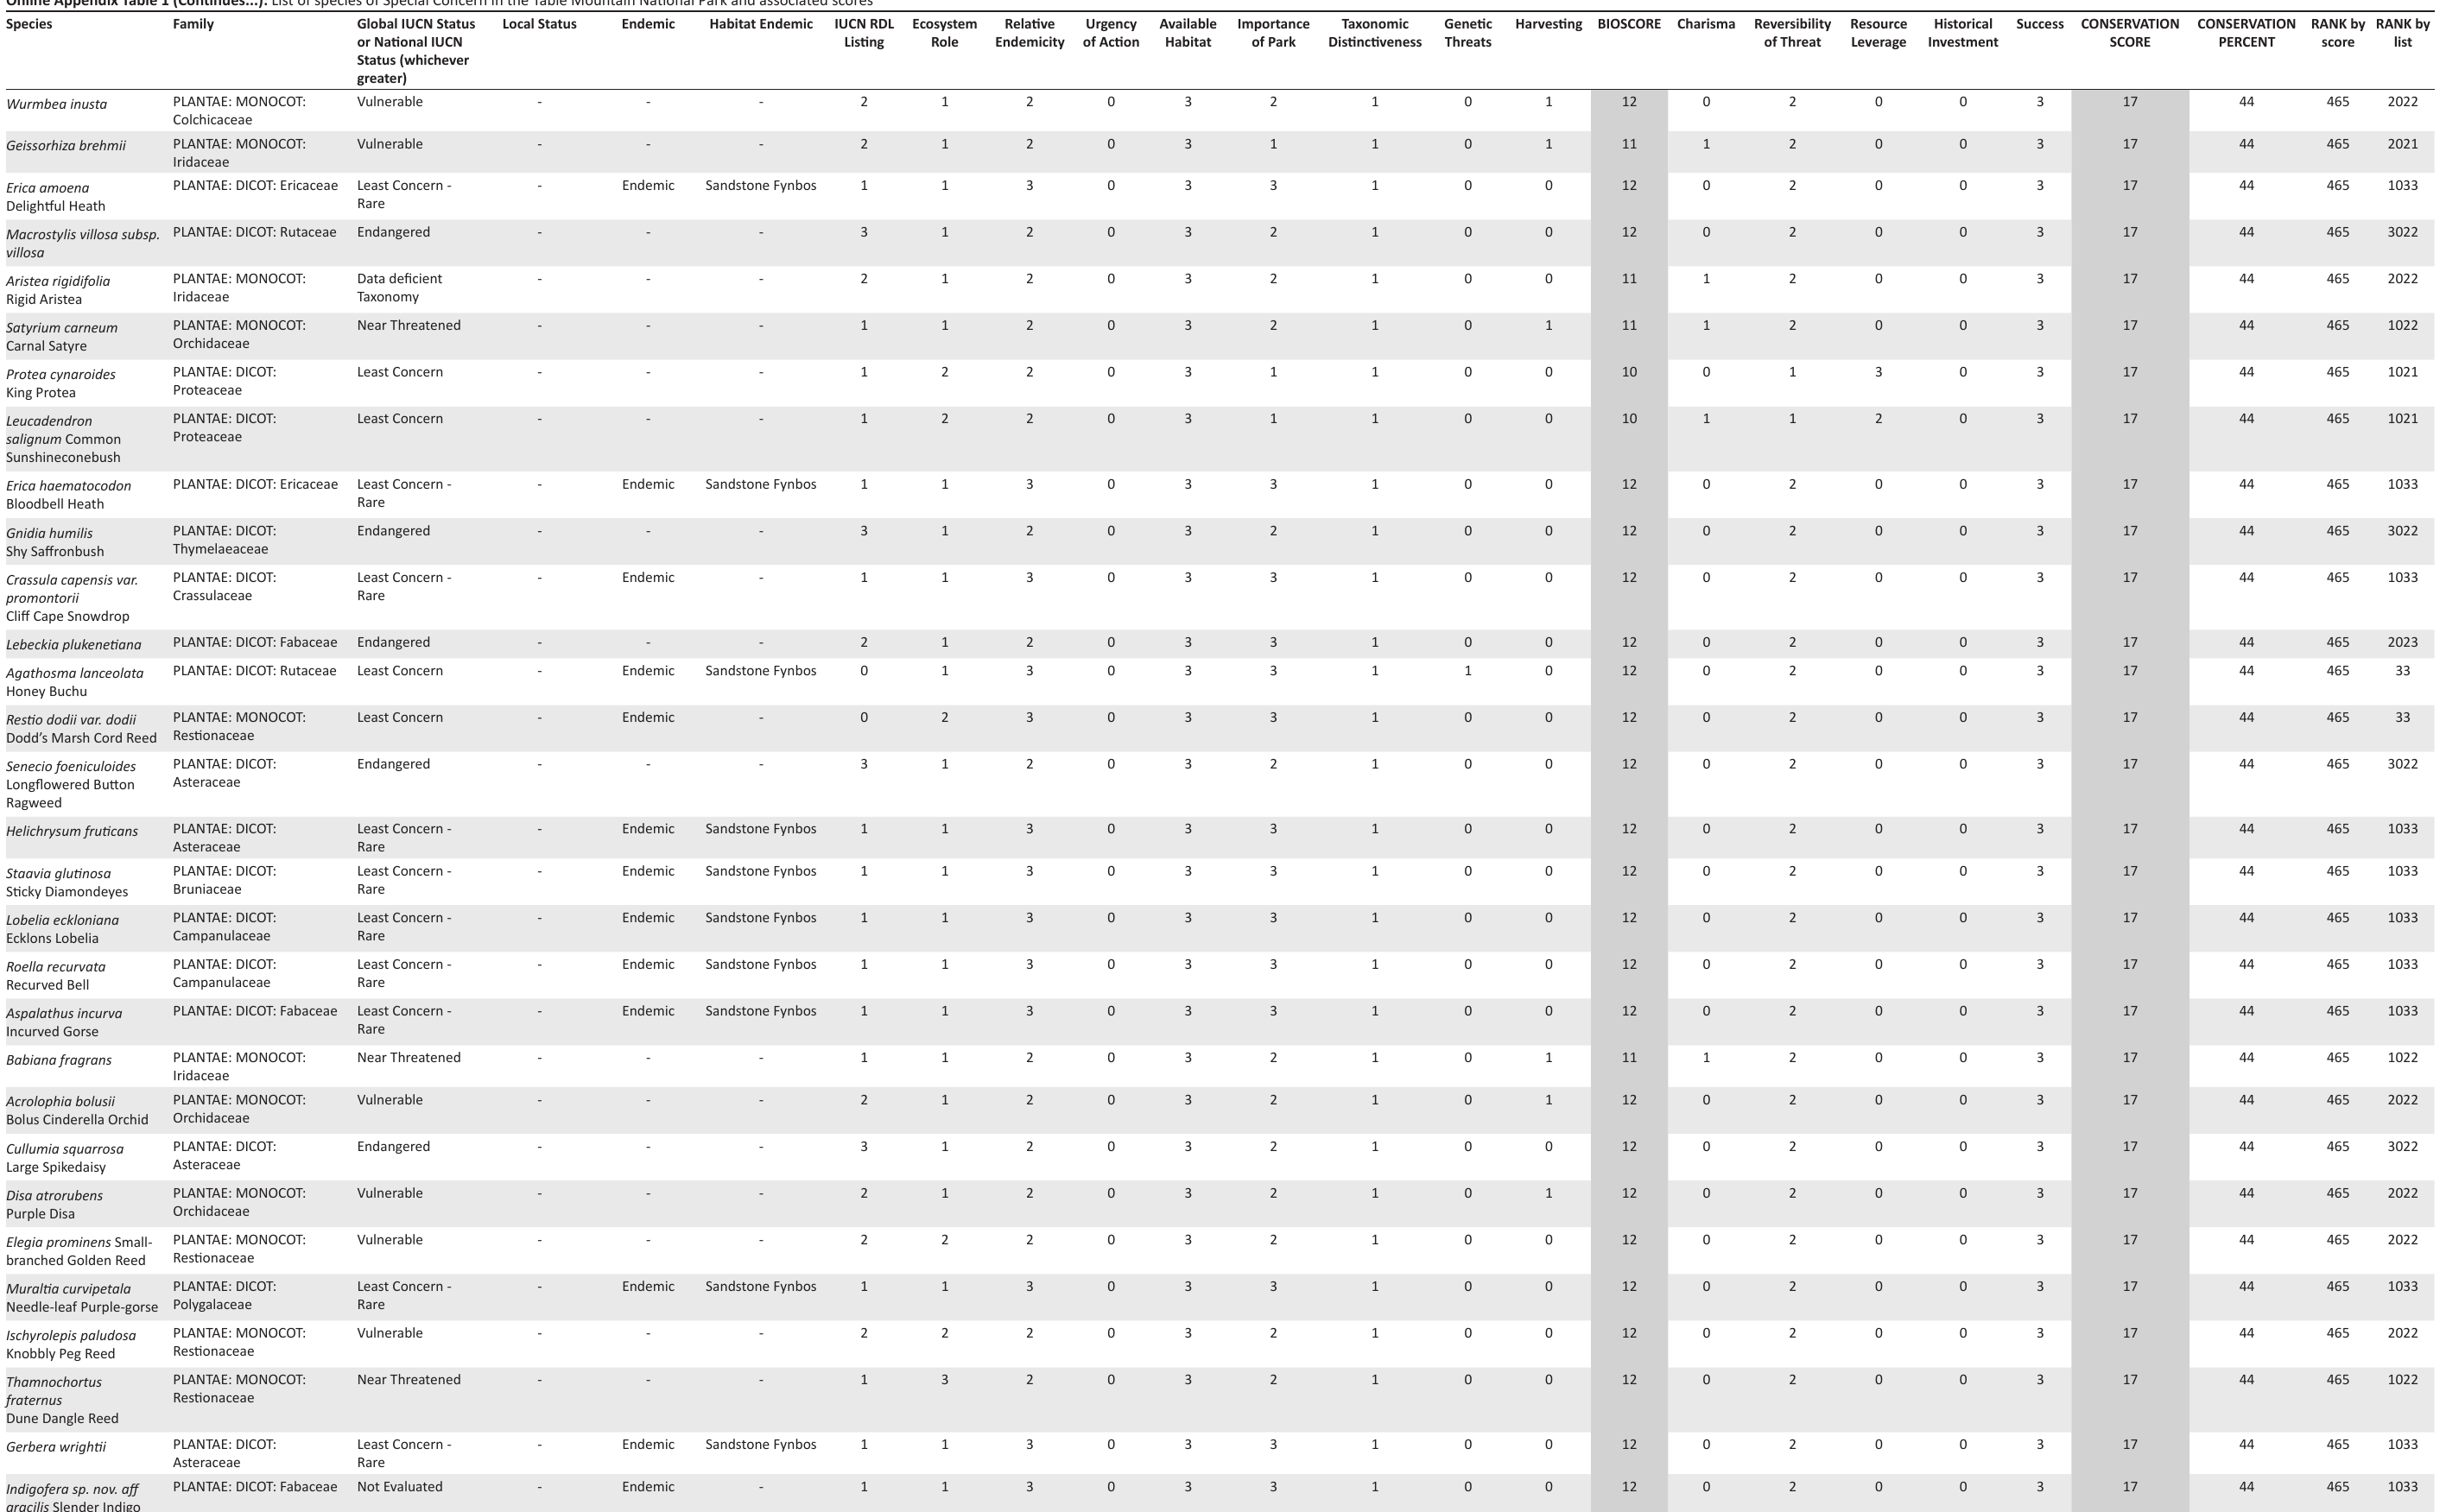
Online Appendix Table 1 (Continues...): List of species of Special Concern in the Table Mountain National Park and associated